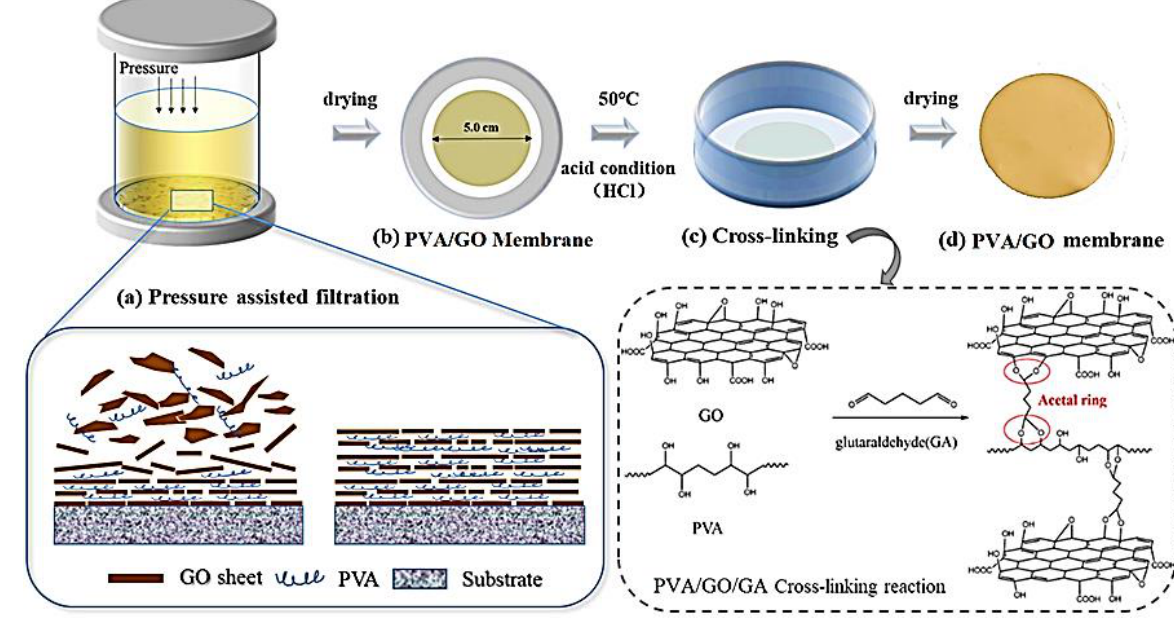
Figure 7. Schematic of GO membrane fabrication: ( a ) pressure-assisted filtration step for construction of PVA/GO thin layer on a microfiltration substrate; ( b ) formation of PVA/GO membrane after drying; ( c ) crosslinking treatment of PVA/GO membrane; and ( d ) formation of crosslinked PVA/GO membrane after drying [115]. GO—graphene oxide; PVA—poly (vinyl alcohol); PVA/GO—poly (vinyl alcohol)/graphene oxide. Reproduced with permission from ref. [115]. Copyright 2020 Elsevier.